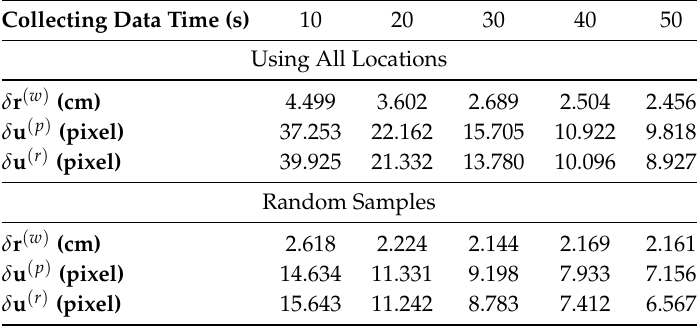
Table 5. The calibration results on Camera Network 2 (CN2) within 1000 experiments of the proposed method. The table shows the results of our method on video sequence where the subject was walking in the room. δ r ( w ) , δ u ( p ) , δ u ( r ) , and δ u ( rr ) denotes the triangulation error, projection error, reprojection error, and relative reprojection error, respectively.